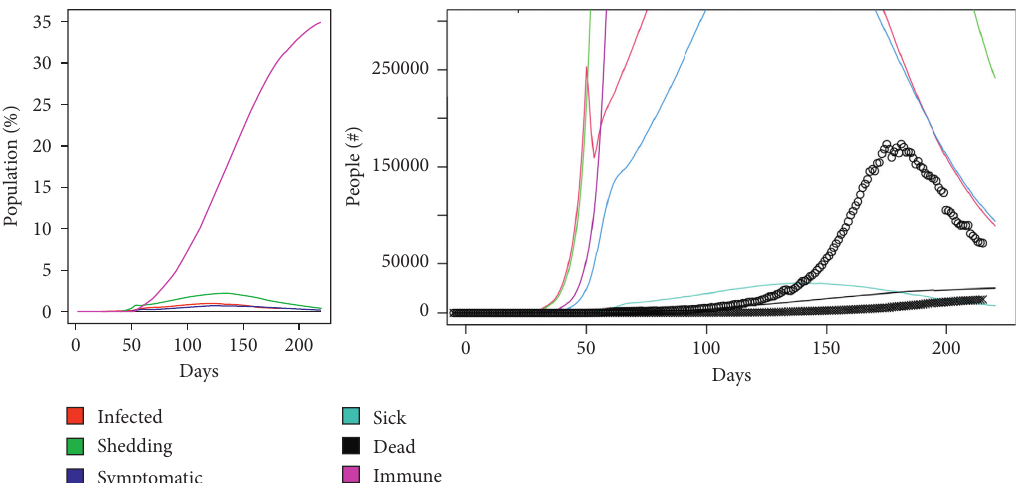
Figure 6: Model simulations implementing social distancing with R w � 0 . 95, and w � 0 . 98. Observed number of fatalities ( × ) and active cases (o) in South Africa. 6 7